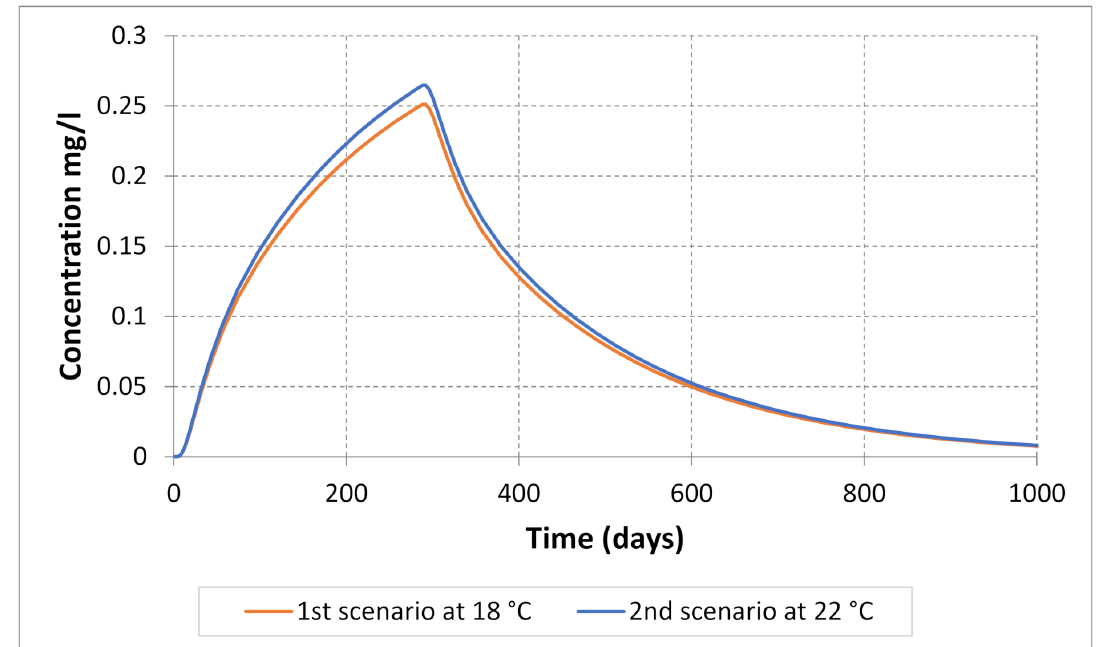
Figure 2. C max of benzene at depth 100 cm—Loam soil.